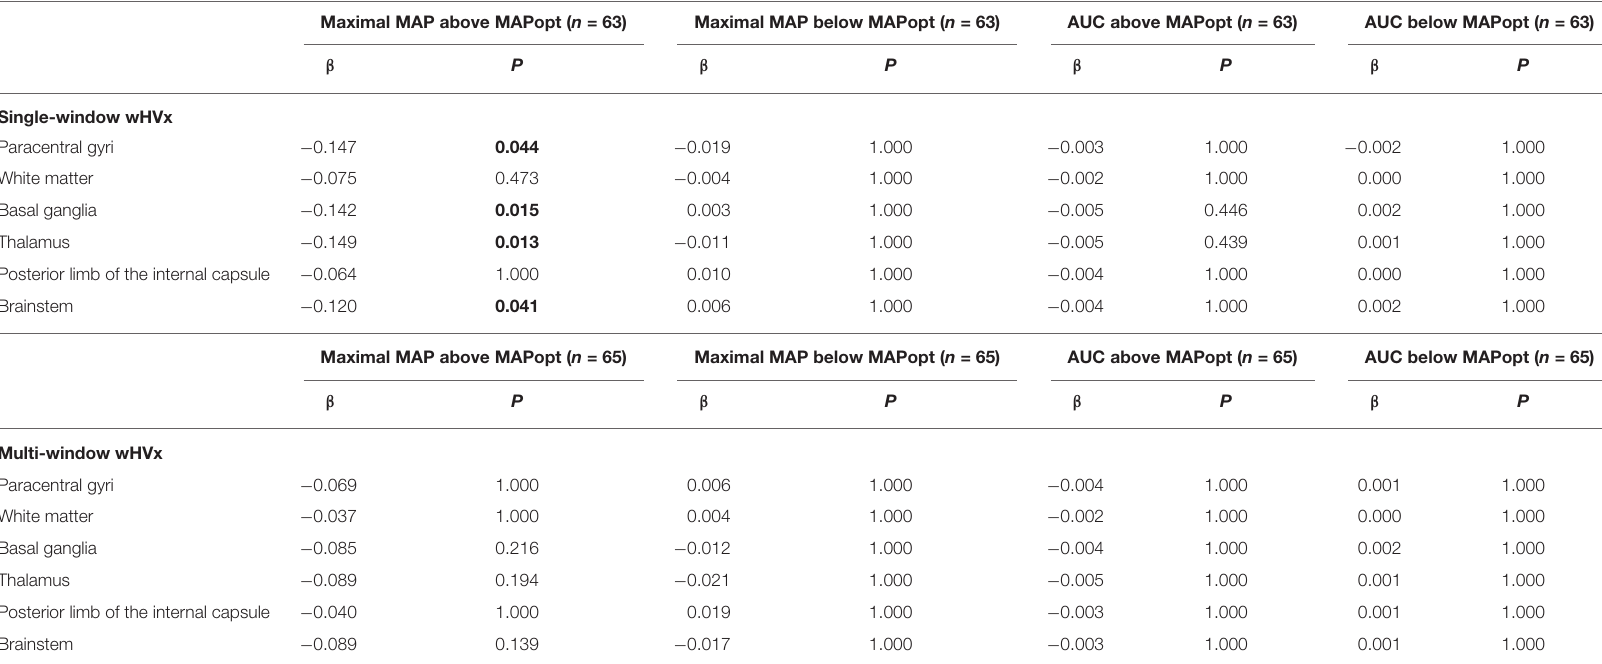
TABLE 4 | Comparisons of blood pressure relative to the MAPopt from wHVx during hypothermia. Maximal MAP above MAPopt ( n = 63) Maximal MAP below MAPopt ( n = 63) AUC above MAPopt ( n = 63) AUC below MAPopt ( n = 63)